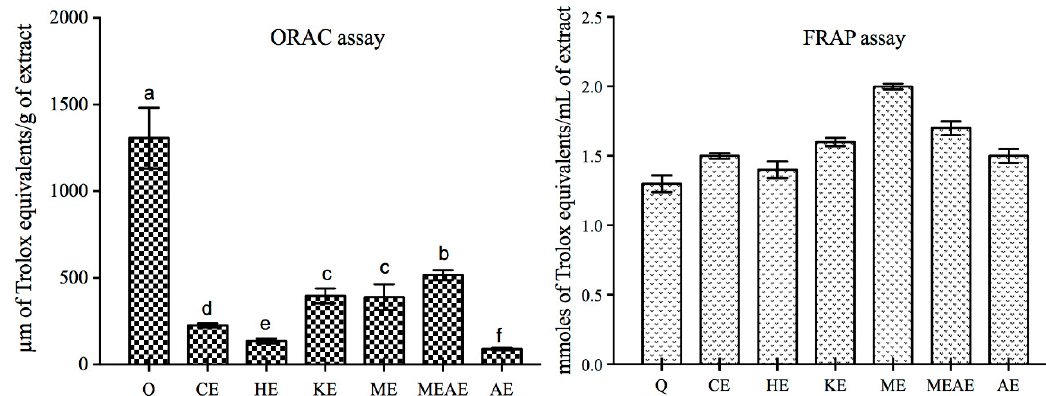
Figure 2. Total antioxidant activity of the extracts from Acacia farnesiana pods by oxygen radical absorbance capacity (ORAC) and ferric-reducing antioxidant power (FRAP) assays. Q = quercetin; CE = chloroformic extract; HE = hexanic extract; KE = ketonic extract; ME = methanolic extract; MEAE = methanolic:aqueous extract and AE = aqueous extract. a,b,c,d,e,f Different letters showed significant difference ( p < 0.05) in the same extract at different concentrations (Kruskal–Wallis test).